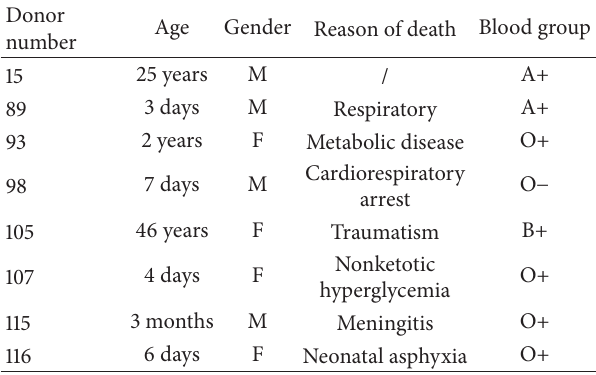
Table 1: Characteristics of the 8 liver donors from which ADHLSCs were